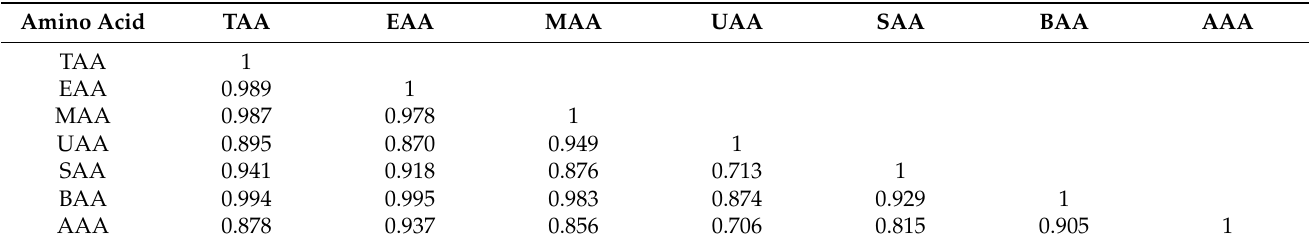
Table 5. Correlational analysis of amino acids in M. importuna under different rotation systems.